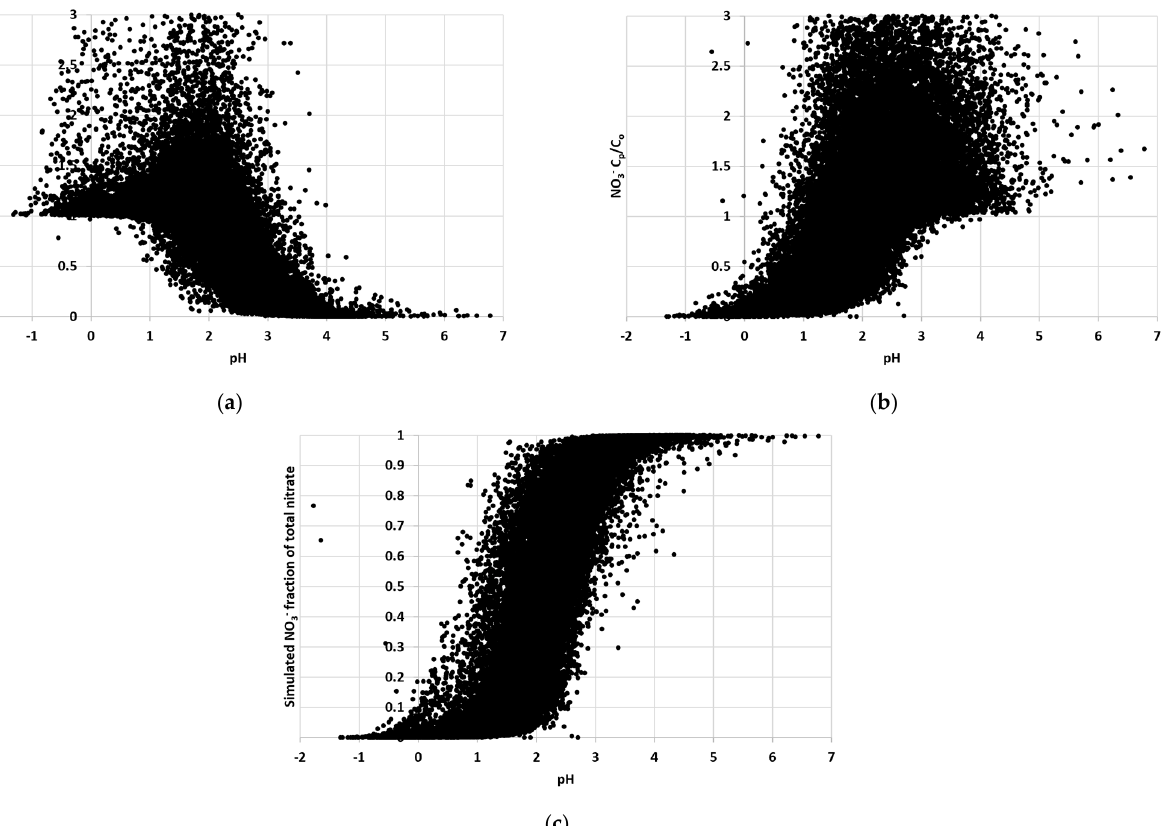
Figure 6. The relationship of under and overprediction of nitrate partitioning with pH at the YRK site, ( a ) HNO 3 C p /C o ratio under different pH; ( b ) NO 3- C p /C o ratio under different pH; ( c ) Simulated NO 3- fraction of total nitrate under different pH.